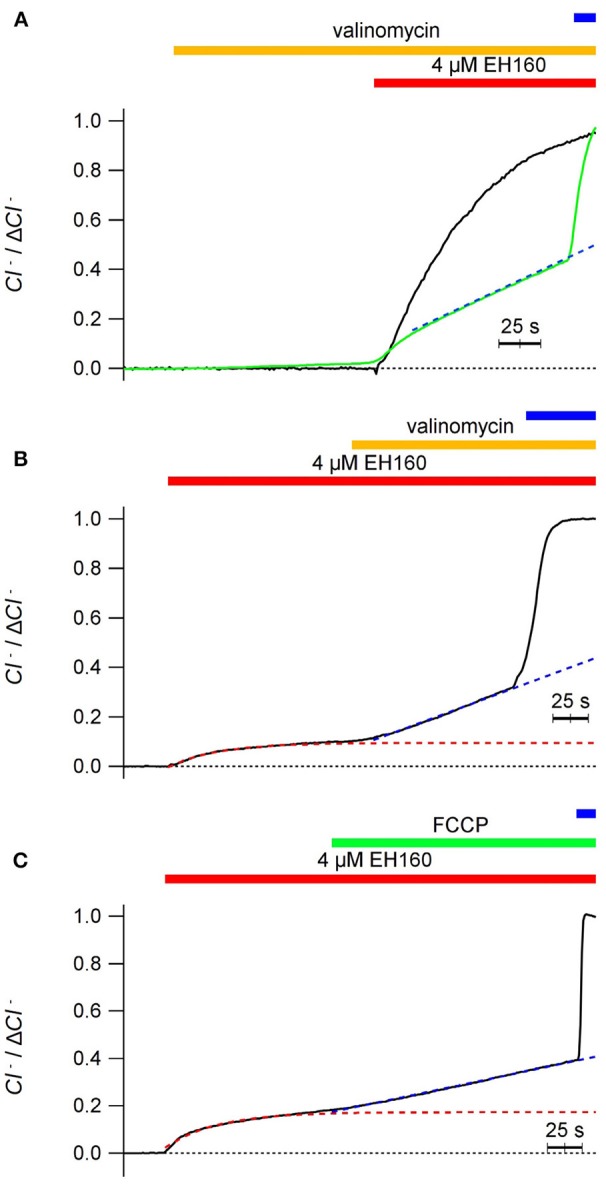
Time course of the external concentration of chloride, revealing the anion efflux induced by the anionophore EH160 recorded in LUV shunted with a second ionophore. In all cases LUV had 450 mM internal potassium chloride and the application of 4 μM of EH160 is indicated by the horizontal (red) bar over the traces. Application of 0.5 ng/ml of valinomycin or 0.25 μg/ml of FCCP is indicated by the middle horizontal bar. The upper horizontal bar indicate the addition of detergent. Data was normalized by the maximum anion change, ΔCl−. In panel (A), the anionophore was added after the application of valinomicyn in preparations with the external solution containing 450 mM potassium nitrate (black trace) and 450 mM potassium aspartate (green trace); the external solution in panel (B) was 300 mM of potassium sulfate, and in panel (C) was 450 mM potassium gluconate. The blue broken lines are the lineal fitting of the traces after application of the cation ionophores. The red broken lines in panels (B,C) are the exponential fitting of the traces before the application of the cation ionophores.